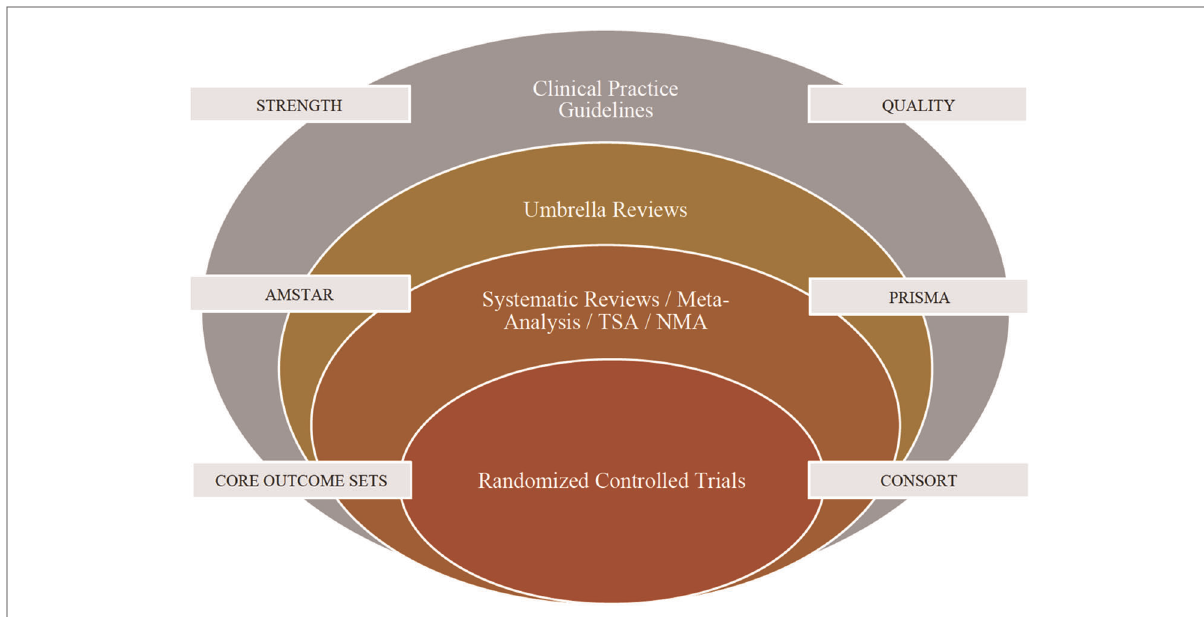
FIGURE 1 Integration of evidence based research speci fi c to randomized controlled trials in pediatric dentistry. NMA, Network Meta-Analysis; TSA, Trial Sequential Analysis; CONSORT, Consolidated Standards of Reporting Trials; AMSTAR, A Measurement Tool to Assess Systematic Reviews; PRISMA, Preferred Reporting Items for Systematic Reviews and